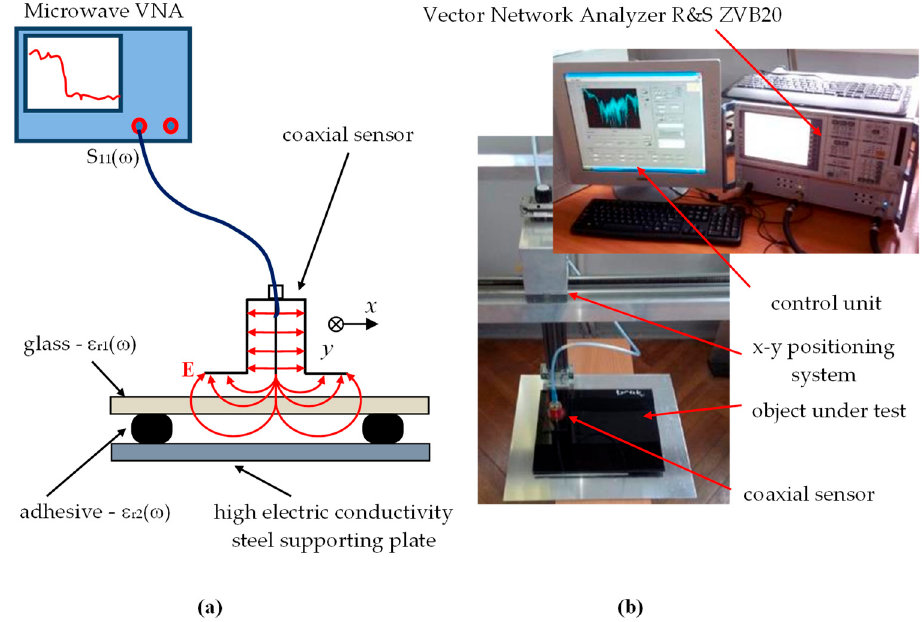
Figure 7. Scheme ( a ) and photo ( b ) of microwave imaging system.